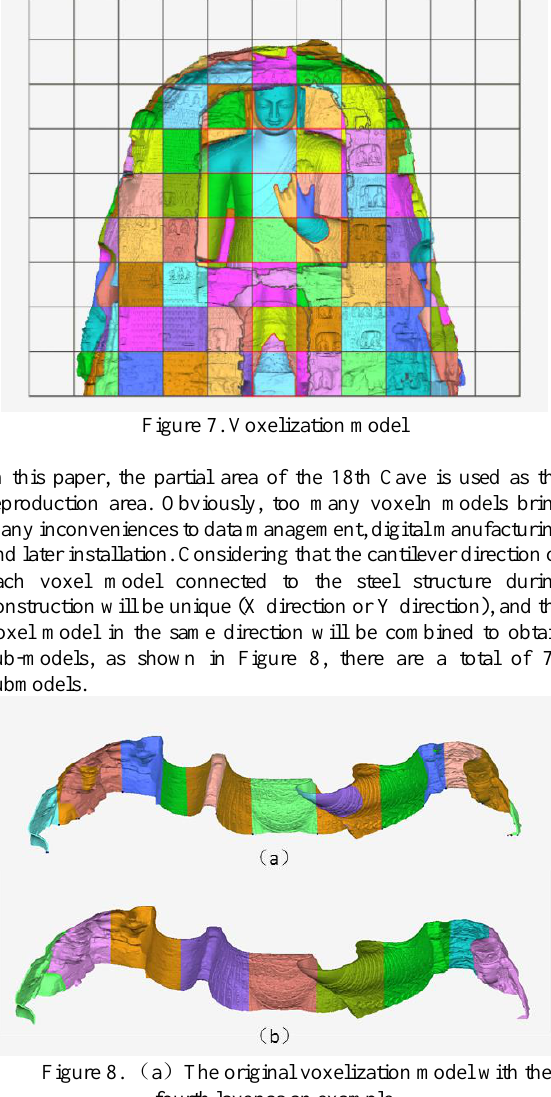
Figure 6. Establishing a Cartesian coordinate system at the center of the entrance